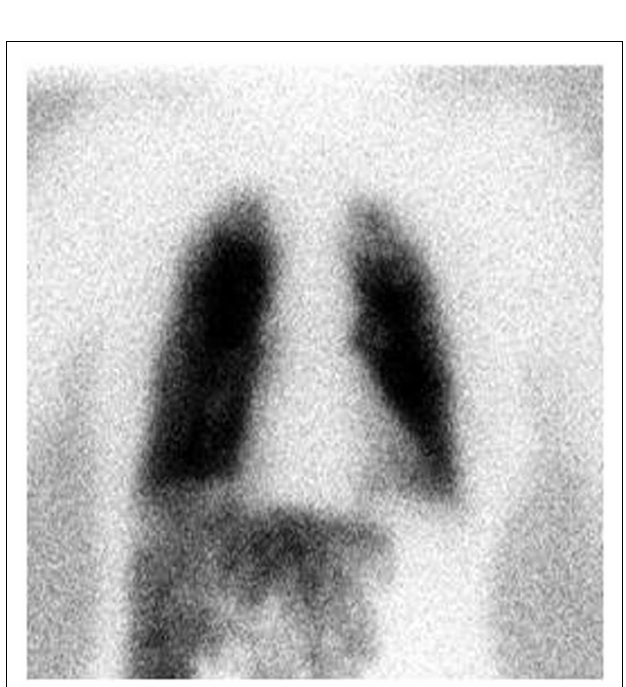
FIGURE 3 | PlanarTc-99m MAA scan demonstrating high LSF (76%) .